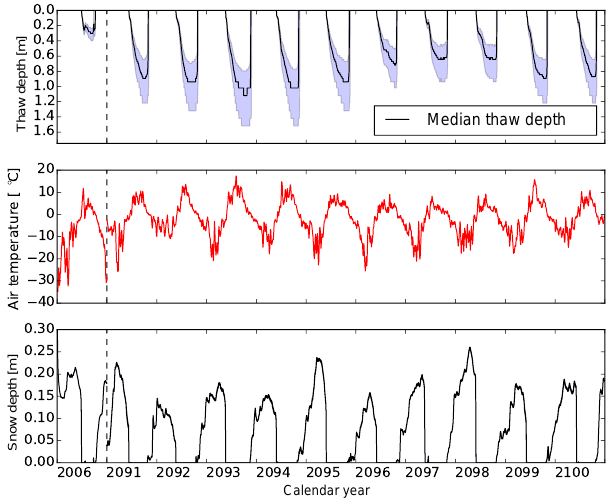
Figure 5. Thaw depth, air temperature, and snow depth time series for years 2006 and 2091 through 2100. The black line in the top plot is the median thaw depth of the ensemble and the blue shaded region is the 95% thaw depth confidence band for the ensemble. The black region in the bottom plot is the 95% snow depth confidence band for the ensemble.